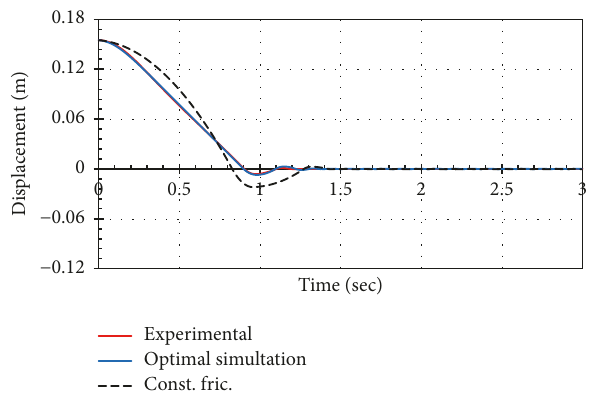
Figure 19: Simulation time history of displacement for the fric- tion function of measuring displacement and individual best fit and overall best fitting function (without lubrication with initial displacement of 154.76 mm).